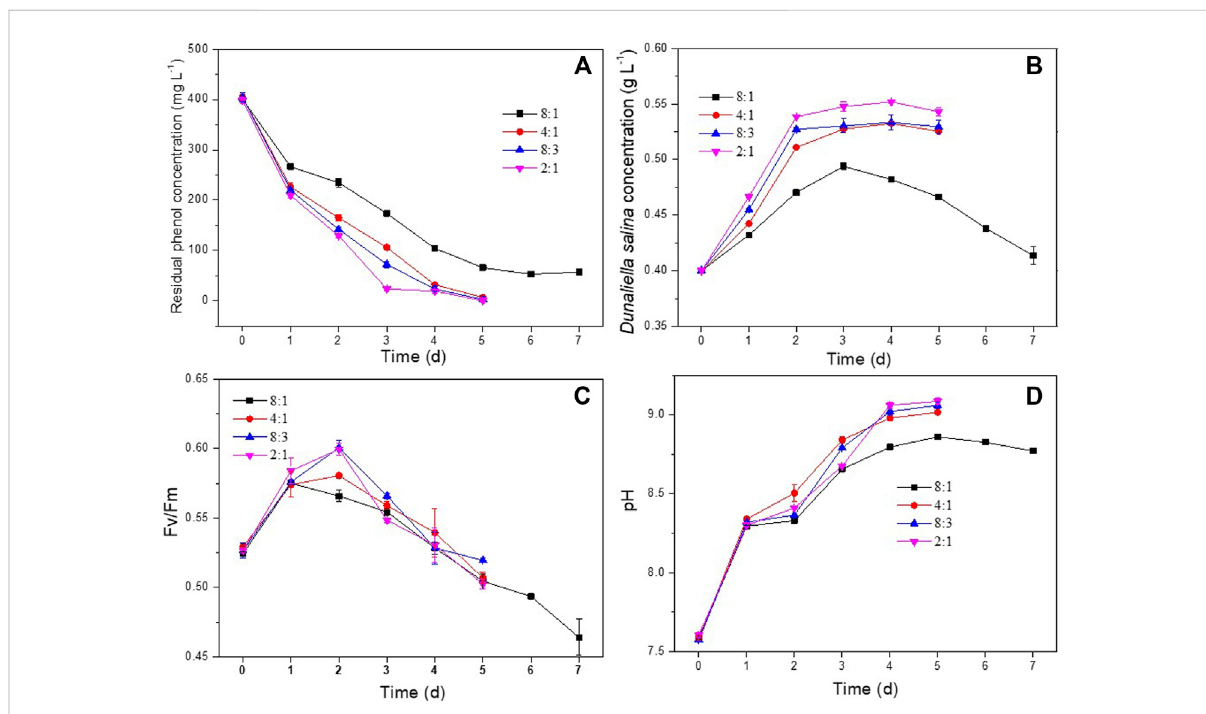
FIGURE 2 Effect of D. salina and H. mongoliensis incubation ratio on phenol degradation and the growth of D. salina : the residual phenol concentrations (A) , biomass concentrations (B) and Fv/Fm values (C) of D. salina and pH of culture medium (D) under pH 7.5, 120 μ mol m − 2 s − 1 and 25 ° C